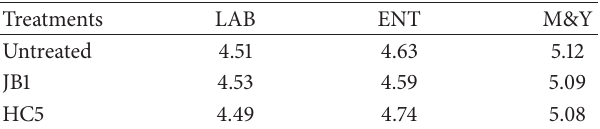
Table 2: Number of lactic acid bacteria (LAB), enterobacteria (ENT), and molds and yeasts (M&Y) in Tanzania grass silage (log cfug −1 ). Treatments LAB ENT M&Y Untreated 7.06 b 3.93 a 4.87 a JB1 9.24 a 2.73 b 2.61 b HC5 9.28 a 2.81 b 2.73 b VC (%) 3.25 3.22 3.19 Means within a column with different superscripts differ significantly ( 𝑃 < 0.05